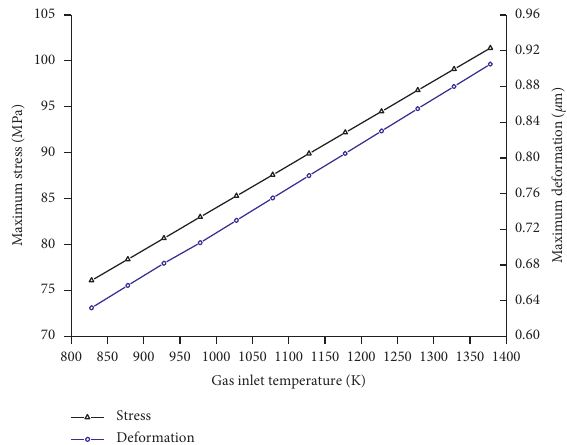
Figure 16: Maximum stress and maximum deformation vary with gas inlet temperature in recuperator.